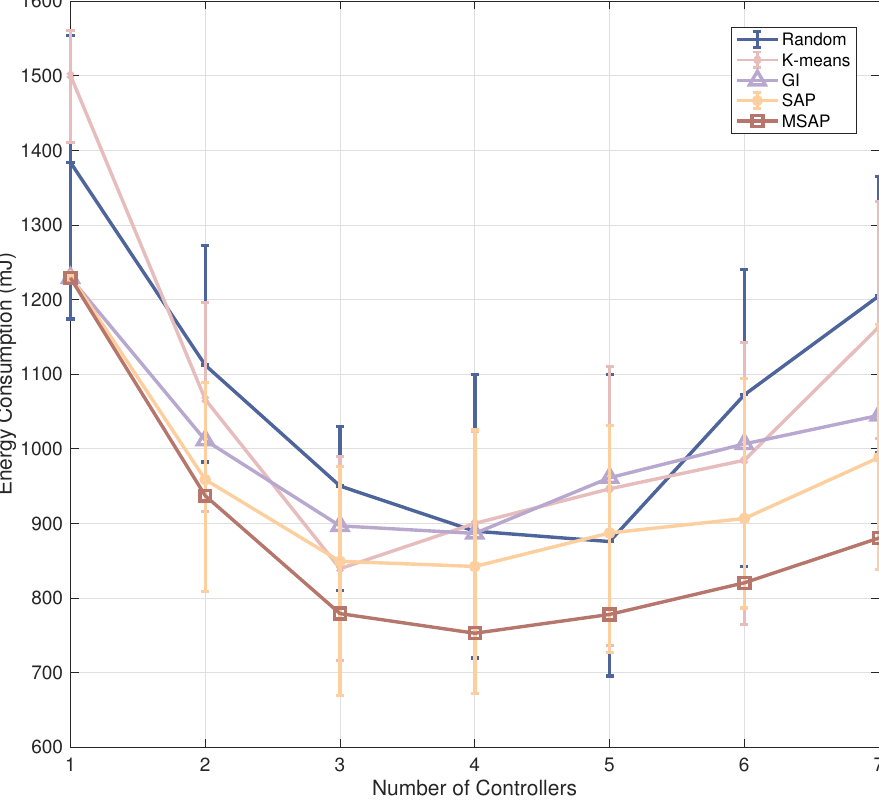
Figure 6. Energy consumption with the different number of controllers in